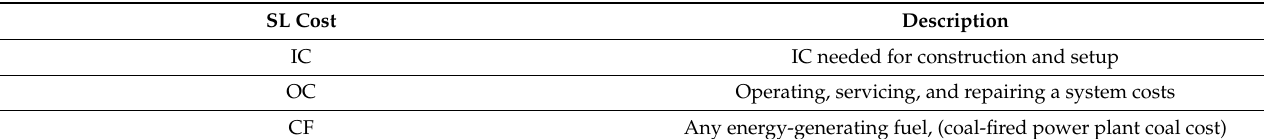
Table 5. The formula for the LCOE.